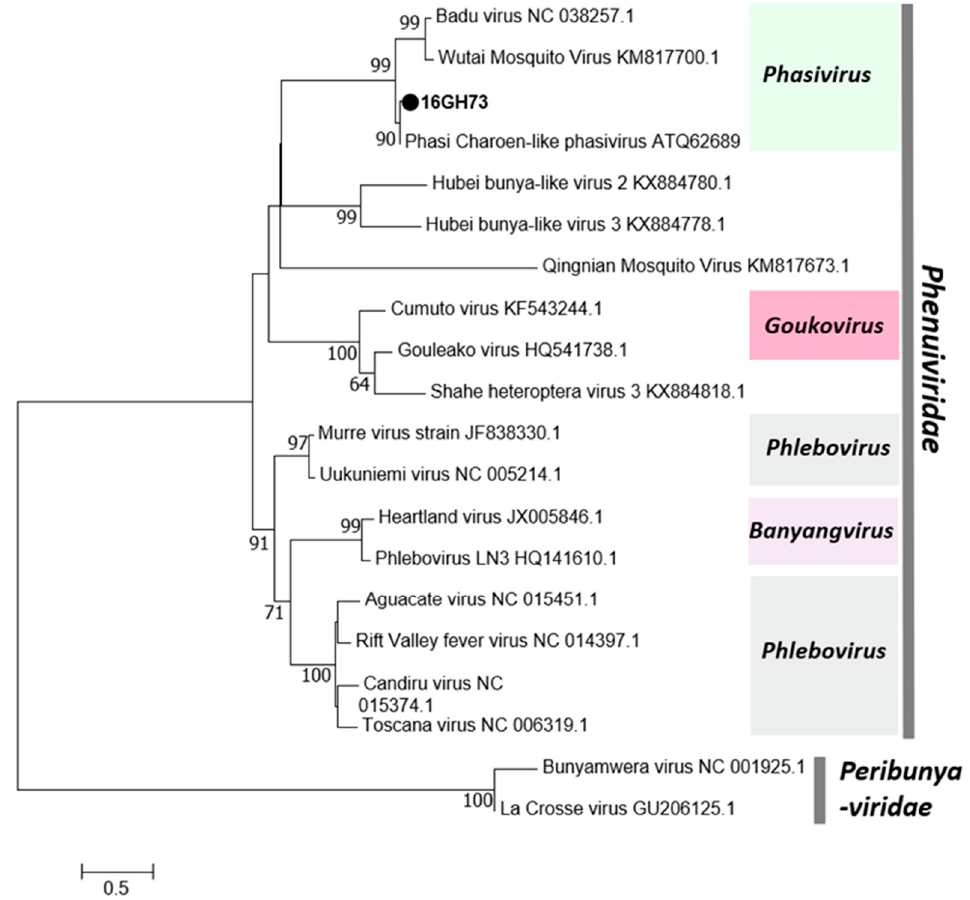
Figure 3. Phylogenetic tree of Phasi Charoen-like Phasivirus (PCLV). Maximum likelihood tree of PCLV constructed with conserved amino acid domains in the RNA-dependent RNA polymerase (RdRp) extracted using MAFFT 7 online version [27] and the Gblocks program [28]. Bootstrap support, from 1000 bootstrap replicates, are indicated by values on the branches. The GenBank accession number of the RdRp, L segment, sequence used is LC498491.